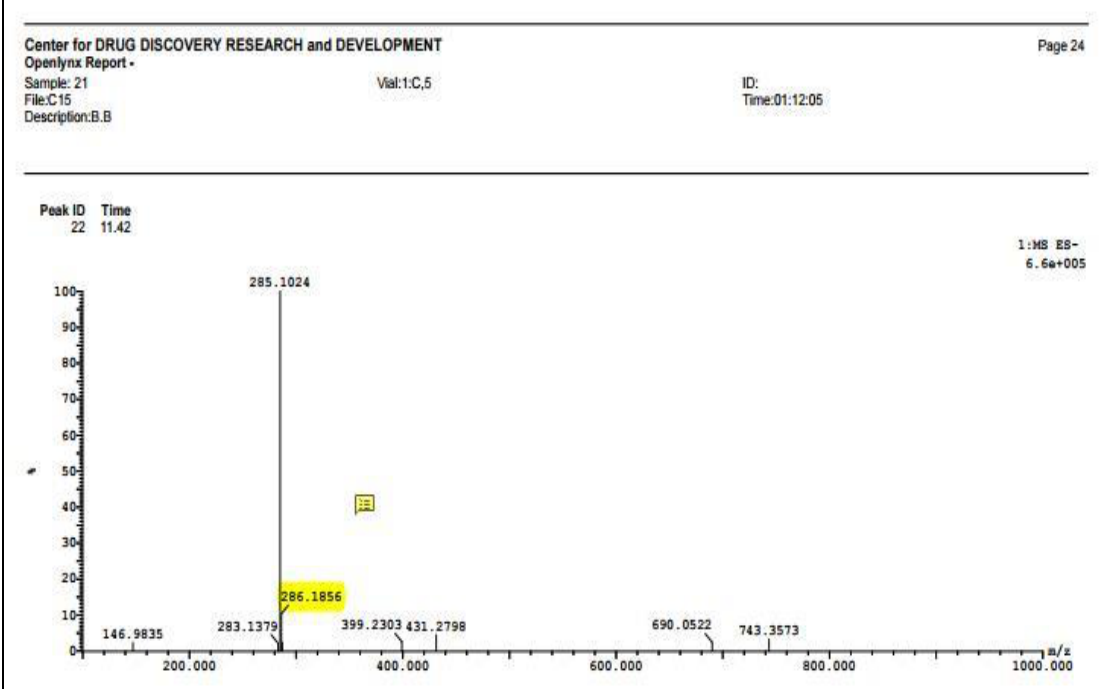
Figure 8. Mass 1 of predicted S1 in B.B fraction in negative ion mode showing M and M-H without adduct formation